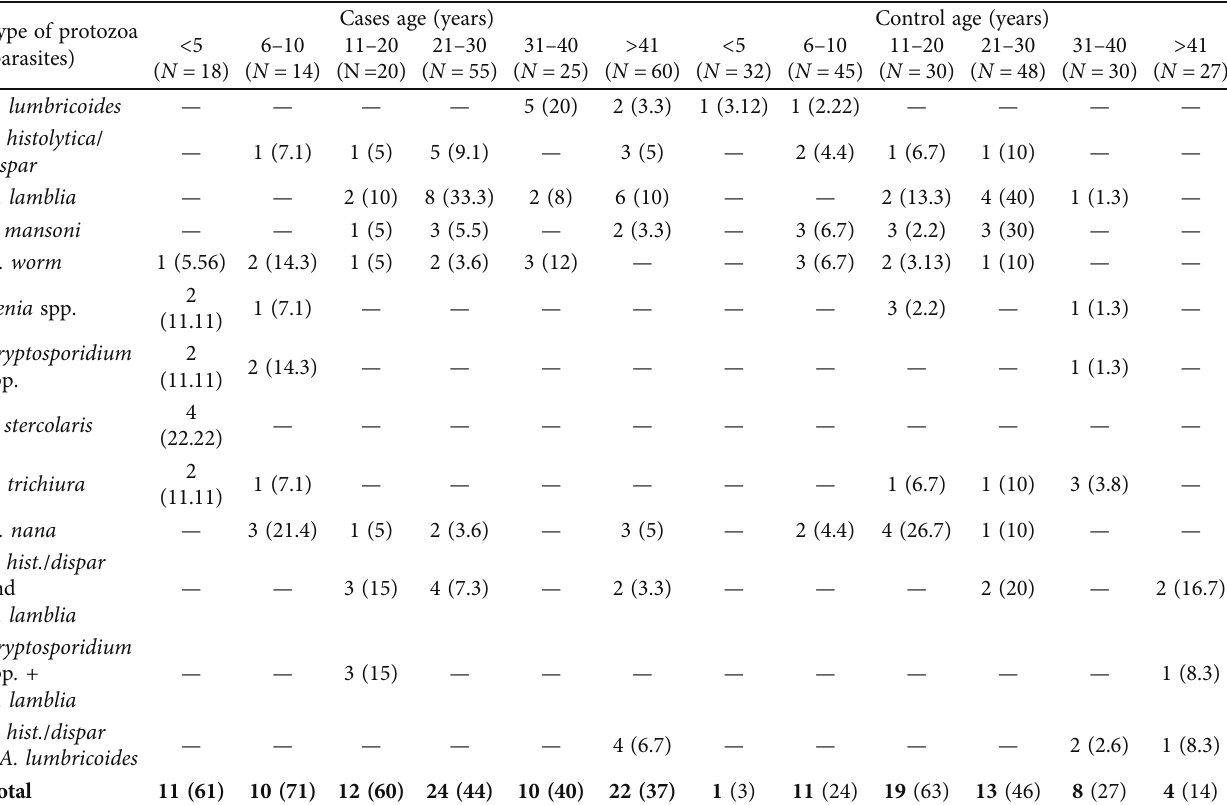
Table 3: Prevalence of intestinal protozoal parasites based on age (years) among diarrheal patients (cases) attending Negelle Borena General Hospital.